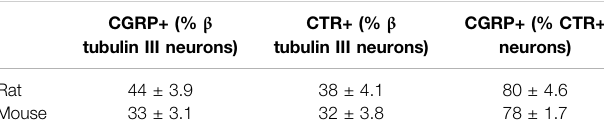
TABLE 1 | Comparison of CGRP and CTR expression and CTR/CGRP co- expression between rat and mouse. CGRP+ (% β tubulin III neurons)